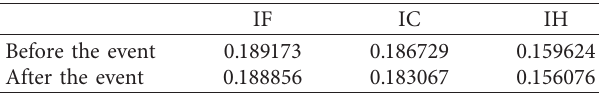
Table 12: The pricing efficiency of IF, IC, and IH dominant contracts.